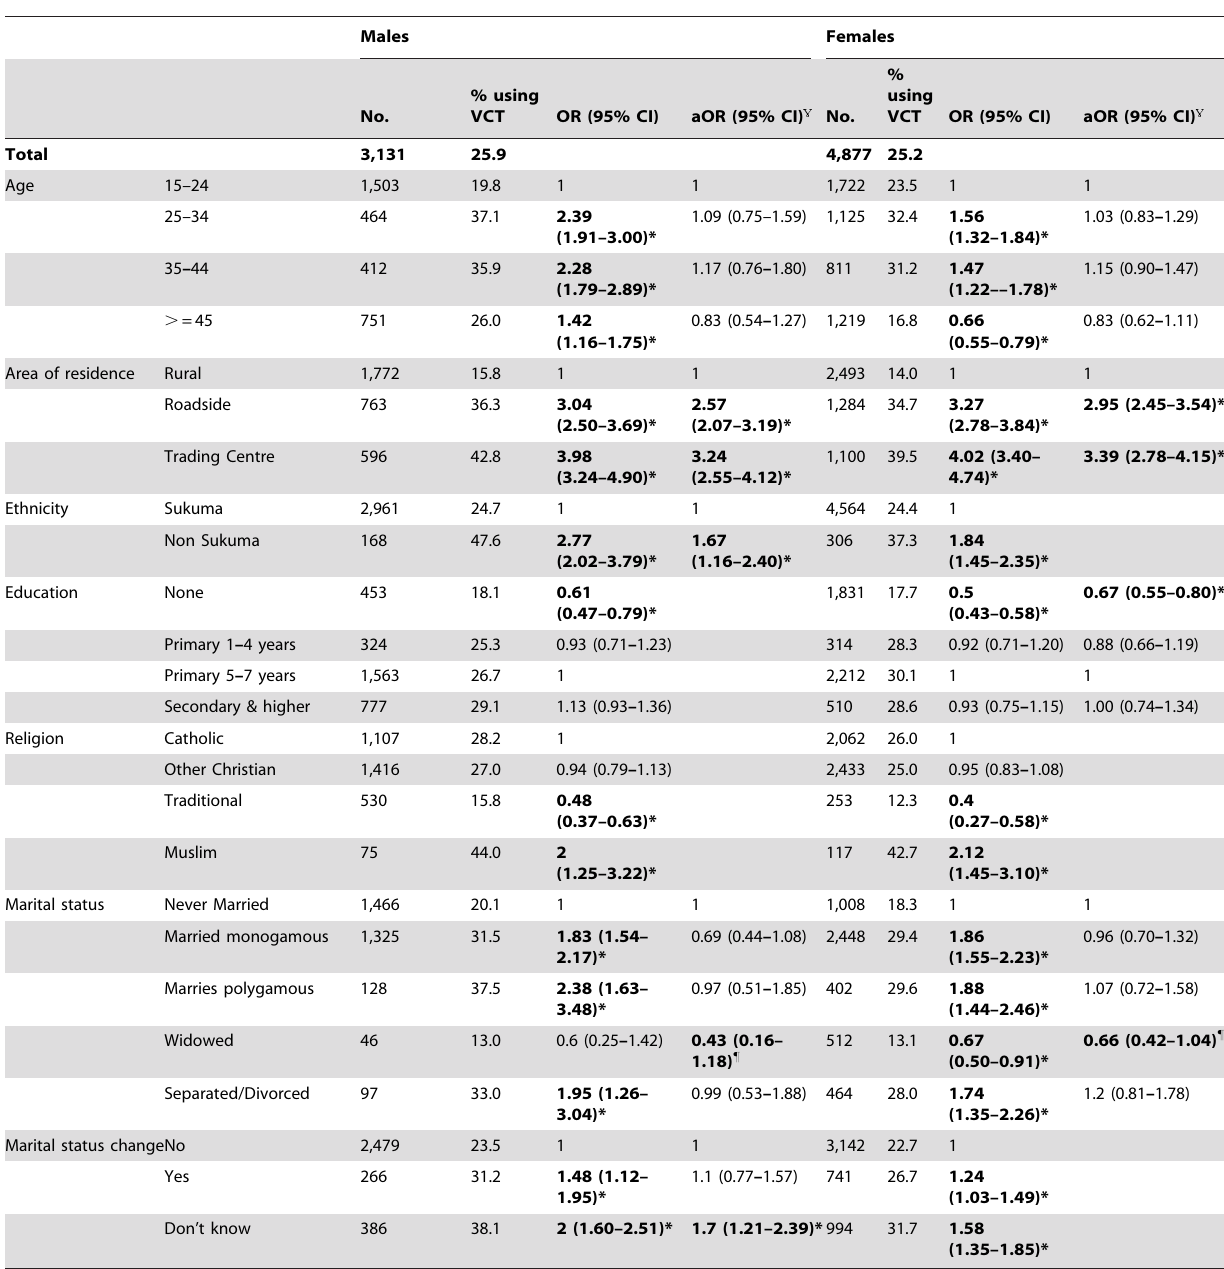
Table 2. Crude and adjusted odds ratios for socio-demographic factors associated with VCT uptake at Sero-6.